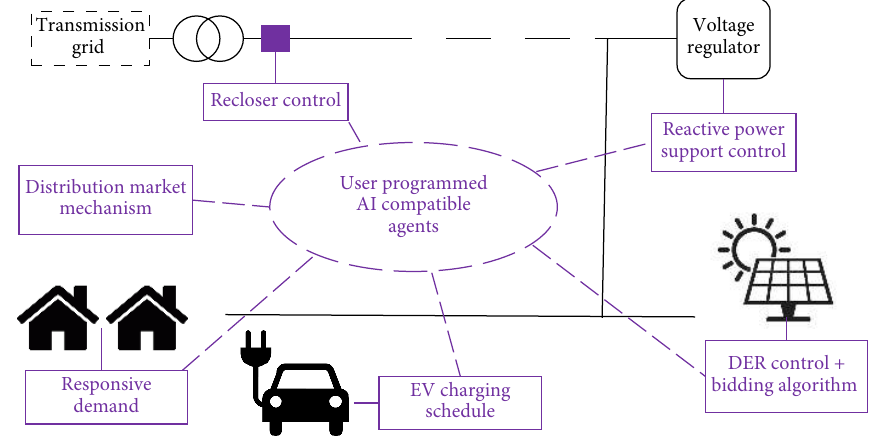
Fig. 1 Envisioned concept of